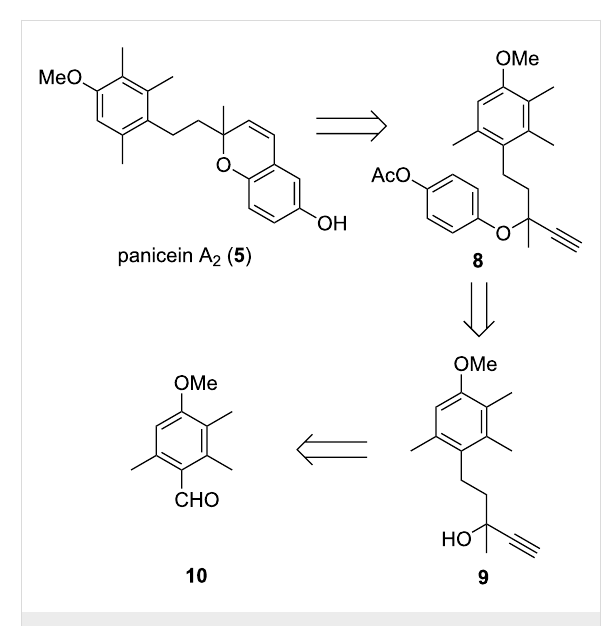
Figure 3: Retrosynthetic analysis of panicein A 2 ( 5